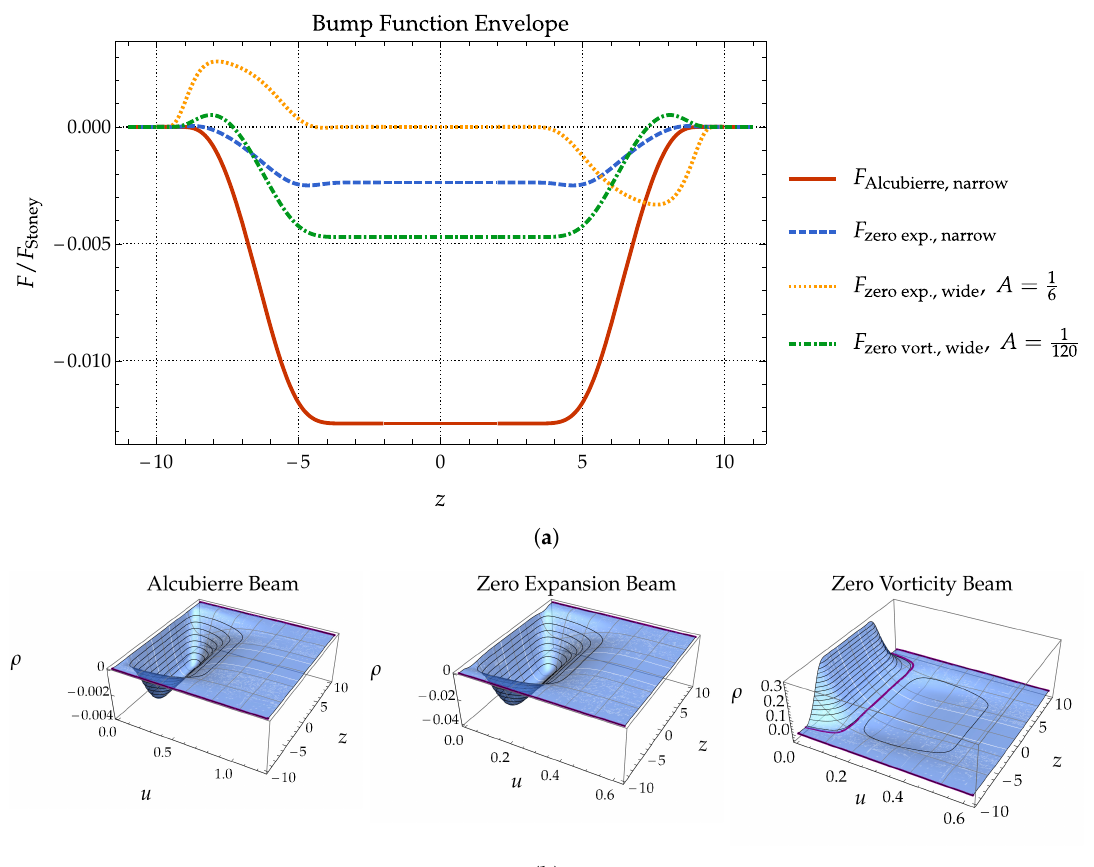
Figure 3. ( a ) Forces F and ( b ) energy densities ρ for beam profiles with smooth bump functions as described by Equation (190); the parameters in these pictures are t = − 1, a = 2, b = 10, A = 0.5, B = C = 1.0 and D = 1.0. The purple lines in the density plots indicate locations where the energy density is zero or indistinguishable from